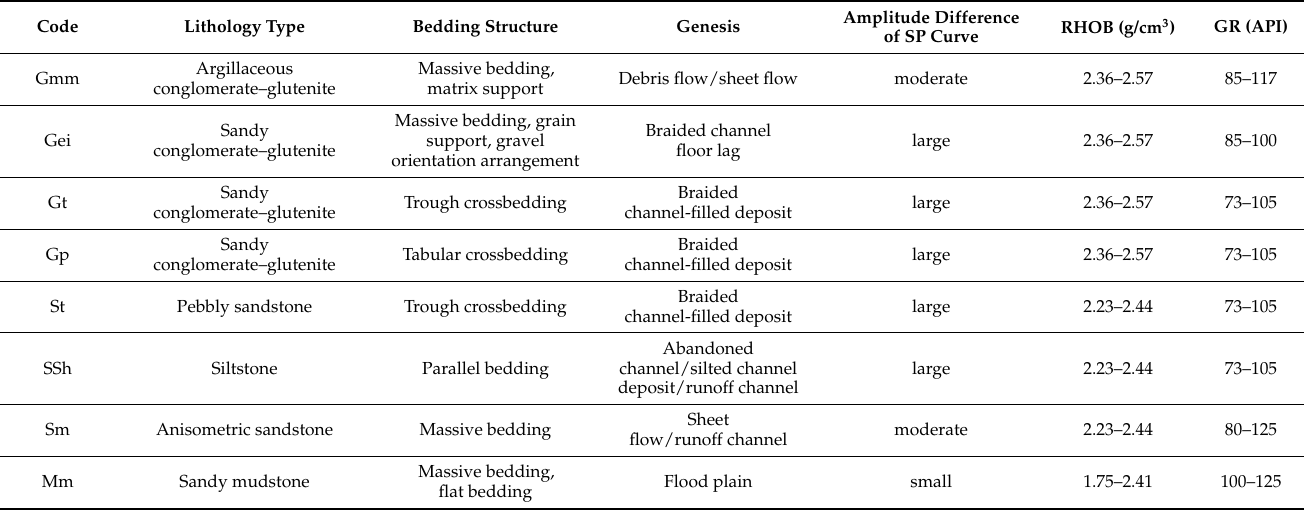
Table 1. Characteristics and genesis of the lithofacies in the Qie12